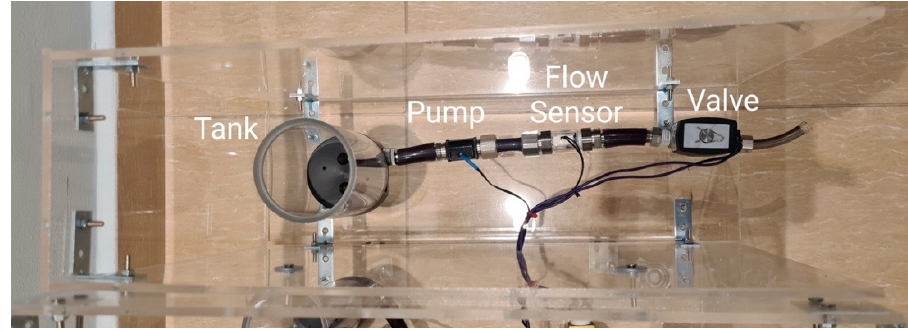
Figure 15. Patient bleeding module.